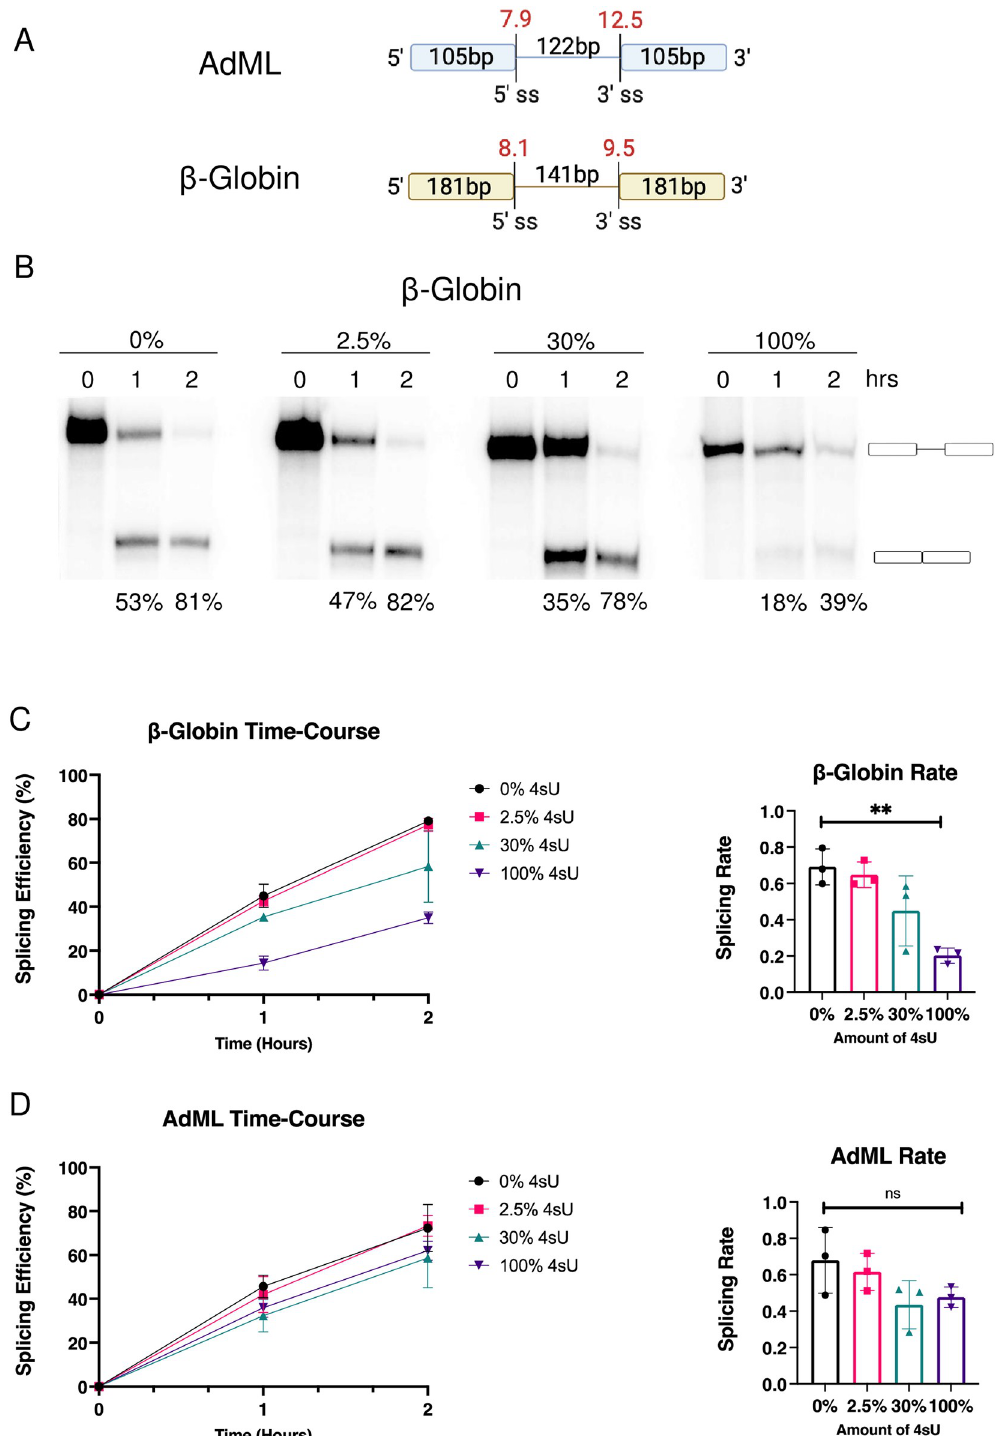
Fig 1. In vitro splicing kinetics of 4sU labeled RNA. (A) Schematic depictions of the AdML and β -Globin minigenes used. Exon and intron sizes, splice sites and strengths (MaxEnt score in red) are indicated. (B) Autoradiogram representing time course behavior of 0%, 2.5%, 30%, and 100% 4sU containing β -Globin pre-mRNAs. Precursor RNA and spliced products are defined on the right of the gel. The numbers under each lane represents the efficiency of splicing. (C) Graphical representation of β -Globin time-course splicing assay splicing efficiencies over time (n = 3) and the corresponding splicing rate. ‘ �� ’ indicates statistically significant difference (ordinary one-way ANOVA, P = 0.0031). (D) Graphical representation of